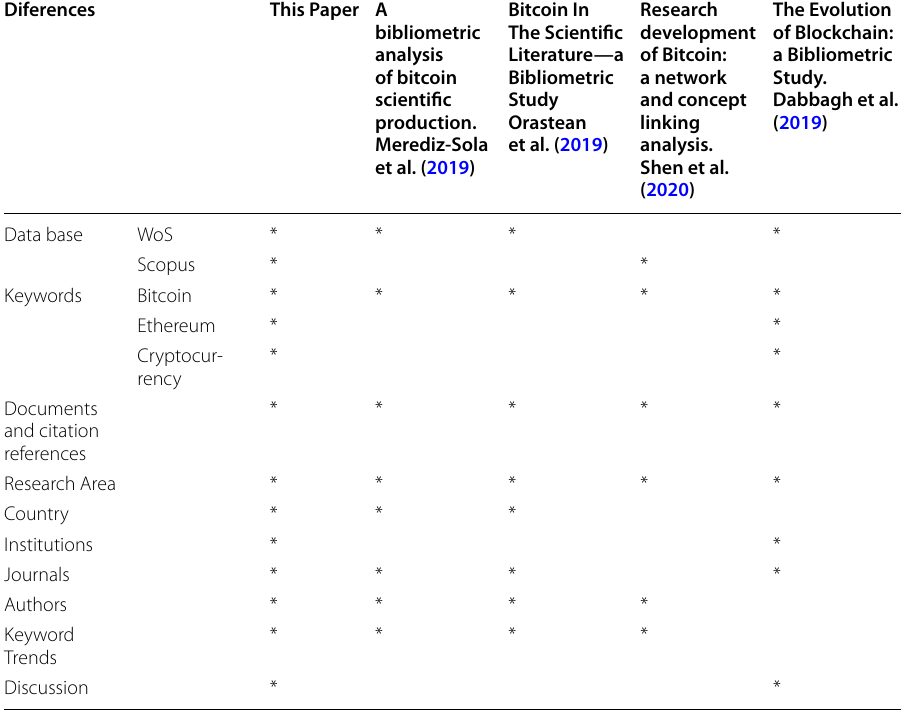
Table 1 Comparison with previous